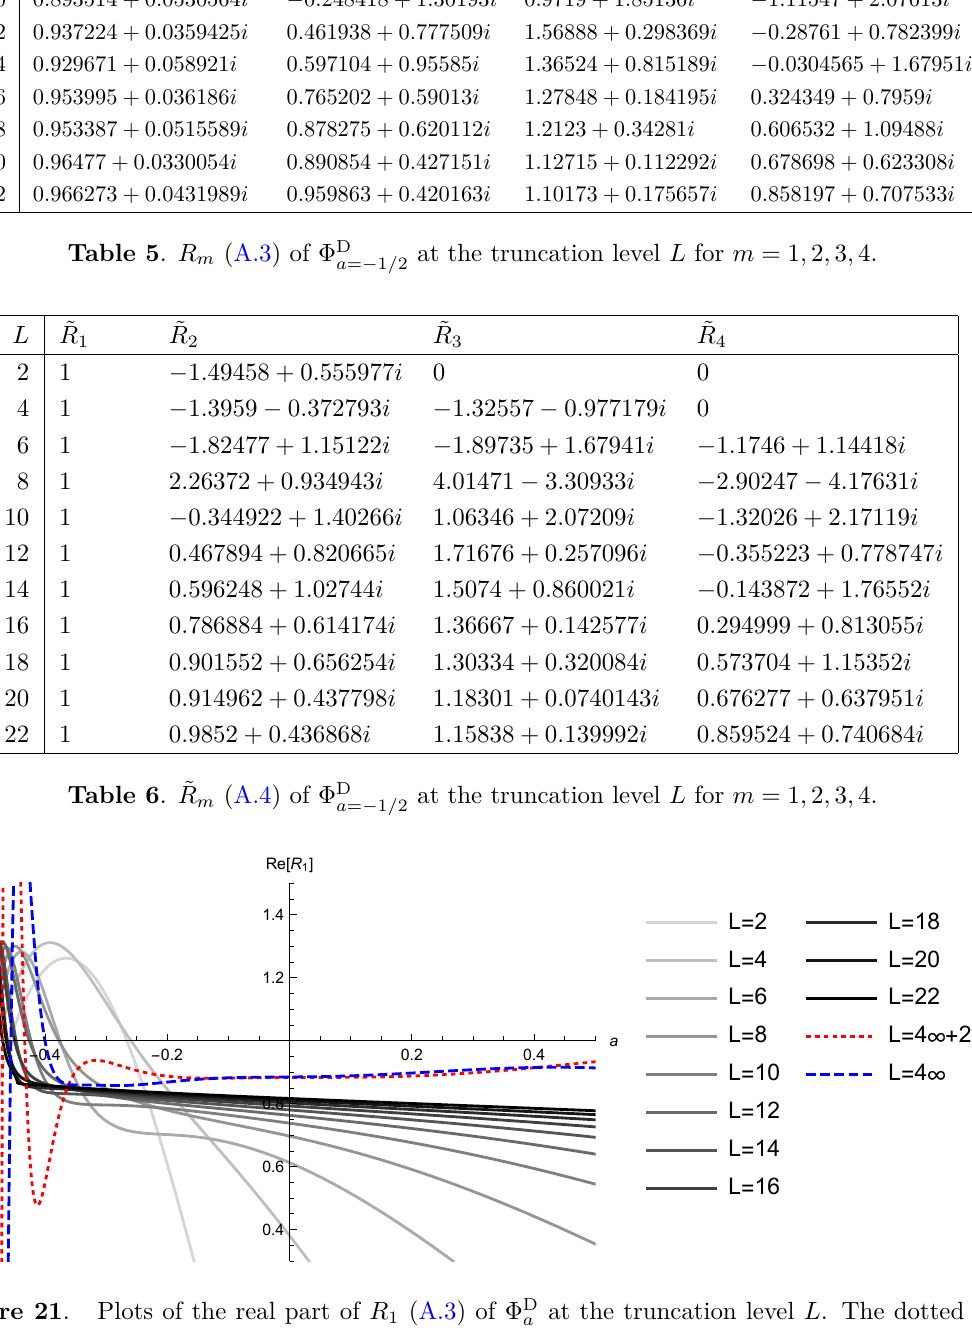
at the truncation level L . The dotted and a